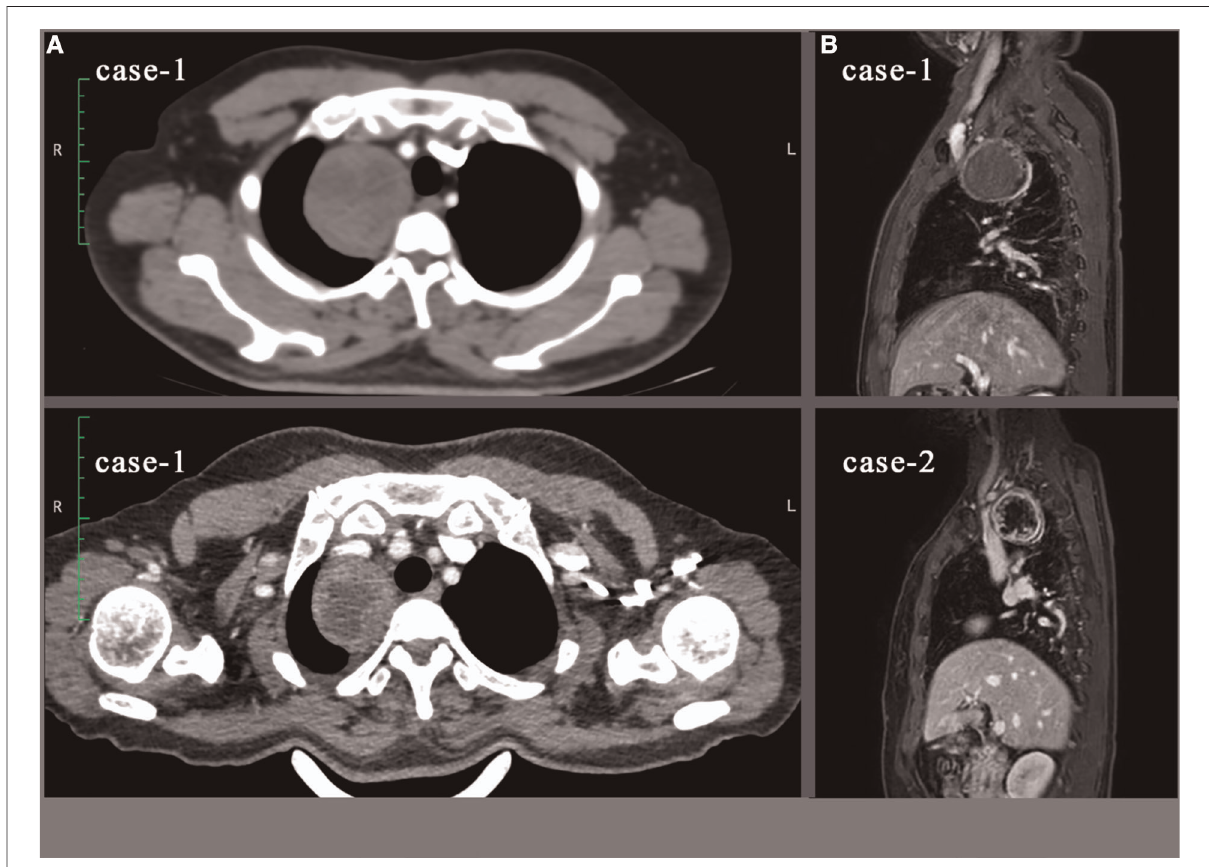
FIGURE 1 Ct and MRI images of both tumors. ( A ): Cross-sectional view of the tumor on CT examination; ( B ): Sagittal view of MRI. In case-2, the tumor has cystic